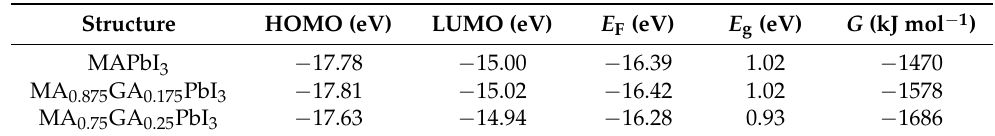
Table 2. Energy levels of MAPbI 3 , MA 0.875 GA 0.125 PbI 3 and MA 0.75 GA 0.25 PbI 3 calculated by molecular orbital calculation.